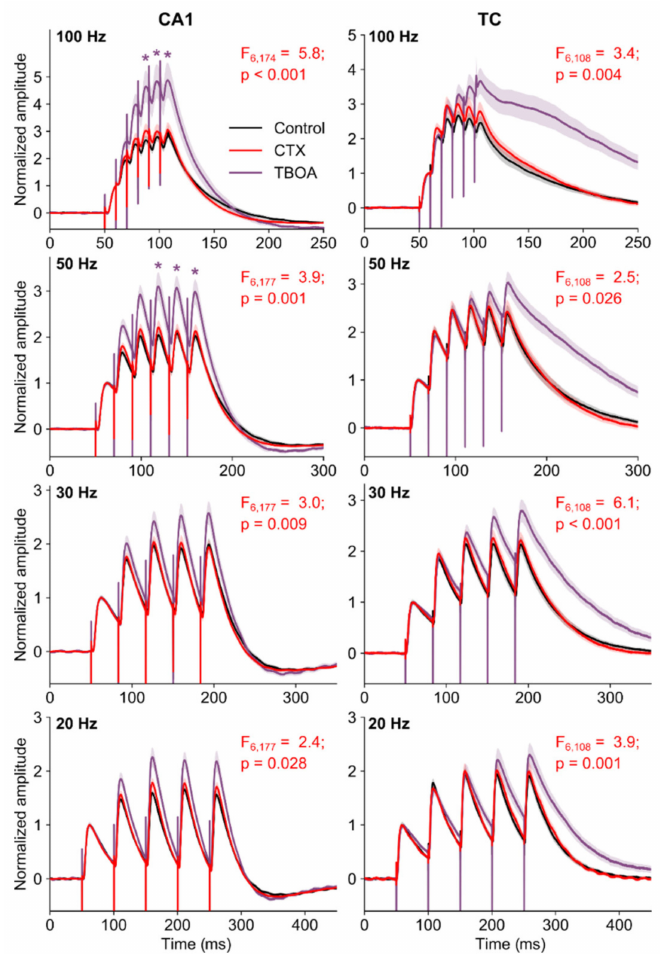
Figure 5. The summation of EPSPs in pyramidal neurons in hippocampus (CA1) and temporal cortex (TC). Graphs show averaged responses across all neurons (control, n = 12; CTX-treated, n = 14; TFB-TBOA, n = 12). A shadow represents the standard error of the mean. The e ff ects of CTX treatment (CTX) and application of TFB-TBOA on the amplitude of EPSP summation was tested with a repeated measures ANOVA following Tukey’s HSD (honestly significant di ff erence) post hoc test: *— p < 0.05 between control and TFB-TBOA-treated